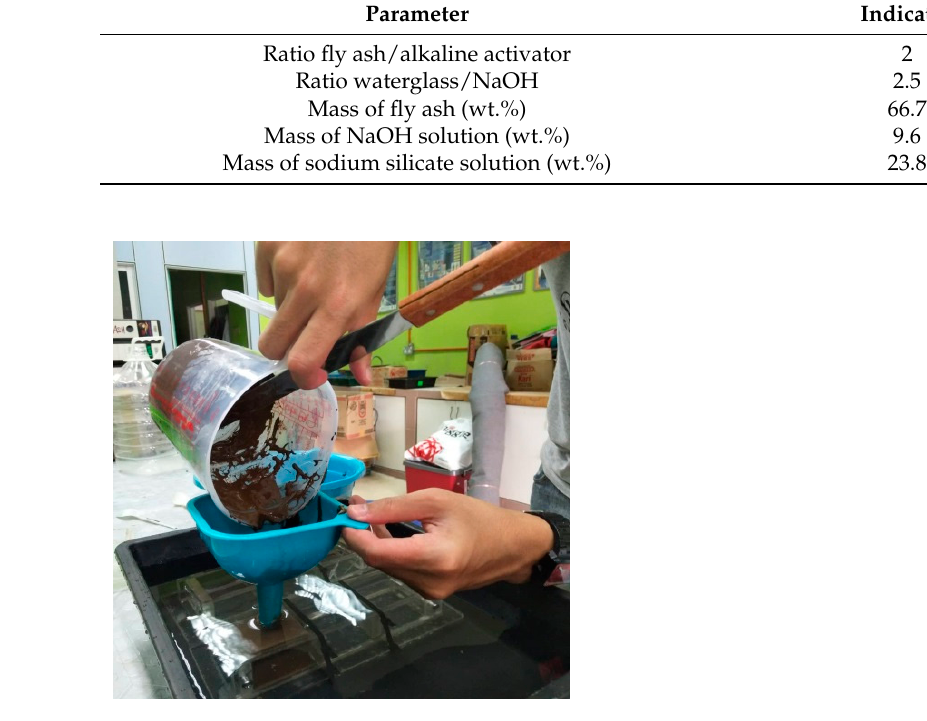
Figure 1. AAFA paste poured into mould in seawater.